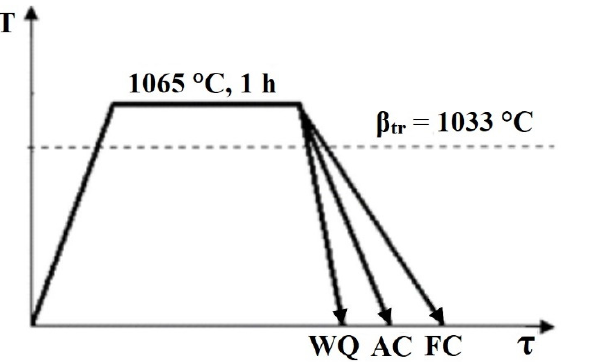
Figure 1. Heat treatment procedure for solution-treated Ti-6Al-4V, where WQ is water quenching, AC—air cooling and FC—furnace cooling.